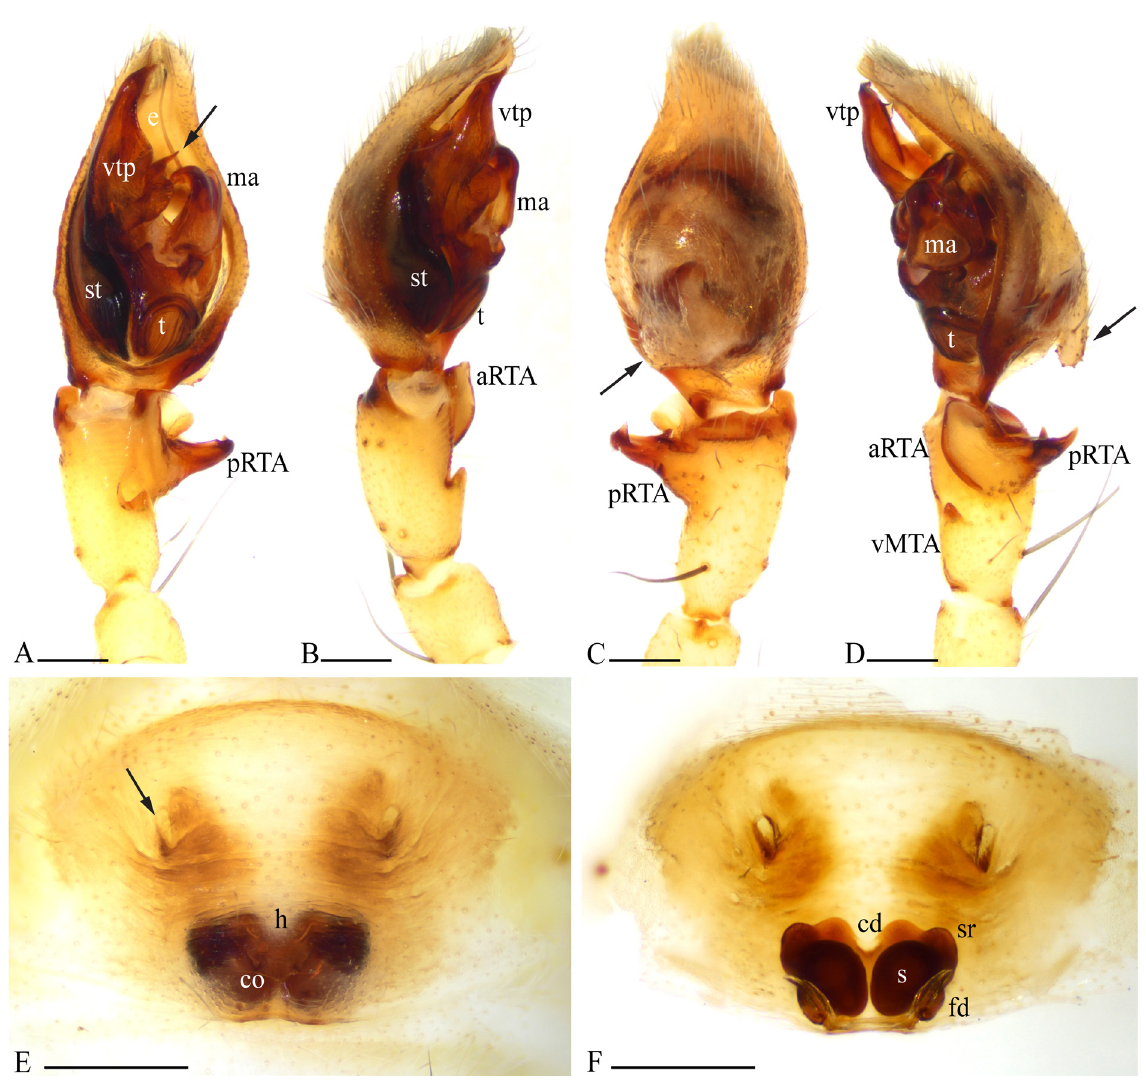
Fig. 14. Anyphaena urieli sp. nov. A–D . Paratype, ♂ (CNAN-T01582). E–F . Paratype, ♀ (CNAN- T01581). A . Pedipalp, ventral view. B . Pedipalp, prolateral view. C . Pedipalp, dorsal view. D . Pedipalp, retrolateral view. E . Epigynum, ventral view. F . Epigynum, dorsal view. Scale bars: 0.2